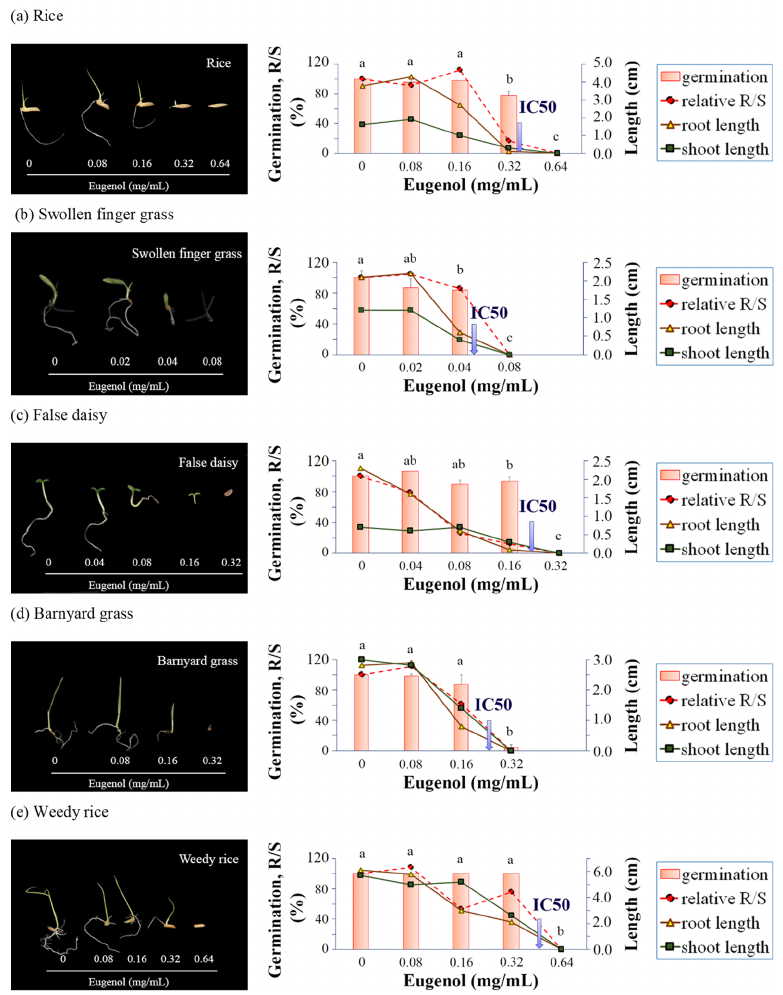
Figure 5. Effects of EU on seed germination and 7 days after germination by means of paper-plate assay. ( a ) rice ( O. sativa L.) ( b ) swollen fingergrass ( C. barbata Sw.) ( c ) false daisy ( E. prostrata (L.) L.) ( d ) barnyard grass ( E. crus-galli (L.) P. Beauv.) ( e ) weedy rice ( O. sativa f. spontanea Roshev . ). The data in the graphs represent the photo of seedlings in the left panel. The arrows in the graphs indi- cate the IC 50 values for germination inhibition. Values are means ± SD of three replications ( n > 100). Different superscript letters on the bars indicated statistically significant differences of germination among different EU concentrations at p < 0.05.